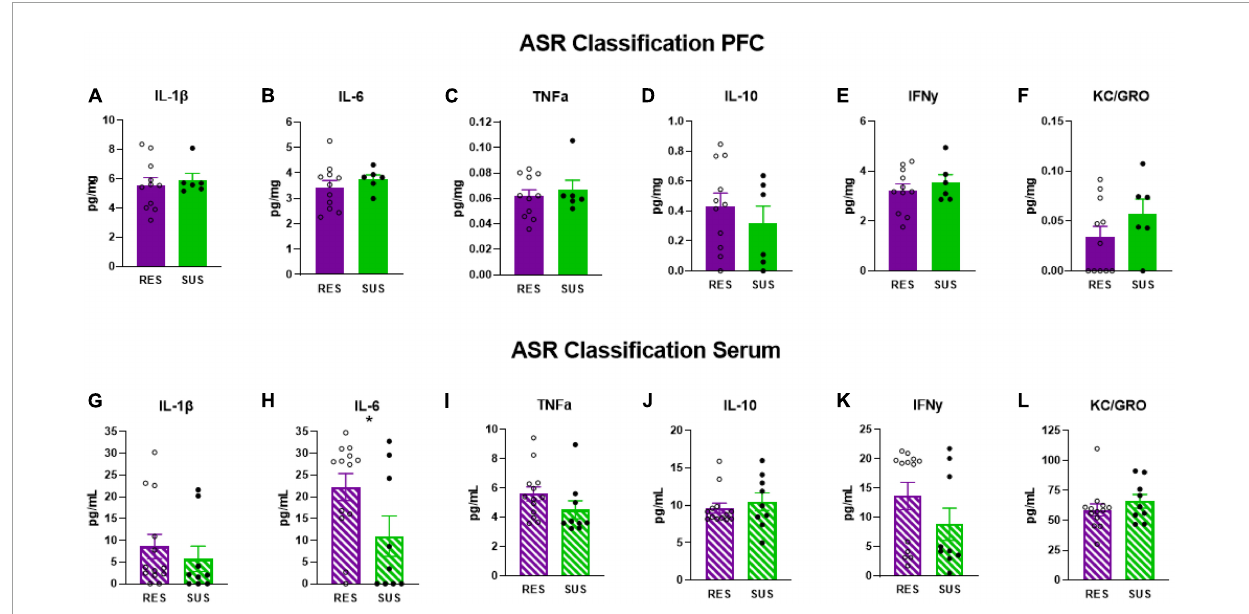
FIGURE3 IL-1 β , IL-6, TNF α , IL-10, IFN γ , and KC/GRO levels in PFC and serum based on ASR classification (PFC: Res n = 11, Sus n = 6, Serum: Res n = 13, Sus n = 9). Protein levels of IL-1 β , IL-6, and TNF α are in pg/mg for PFC and in pg/mL for serum. * p < 0.05.